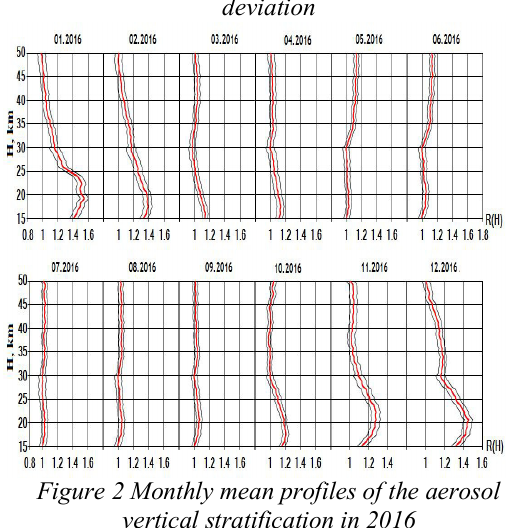
Figure 1 Monthly mean profiles of the aerosol vertical stratification in 2015. Red lines show the mean profiles, black lines show the range of standard deviation